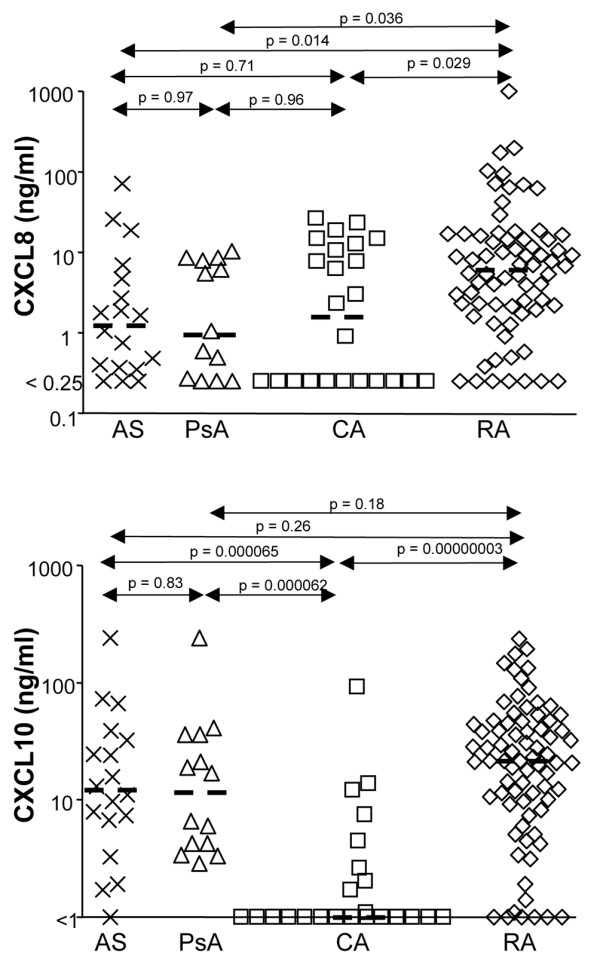
CXCL8 and CXCL10 in synovial fluid of arthritis patients. (a) CXCL10 and (b) CXCL8 concentrations were measured by ELISAs in synovial fluids of patients with ankylosing spondylitis (AS), psoriatic arthritis (PsA) and rheumatoid arthritis (RA), and were compared with chemokine concentrations in the metabolic arthritis patients with crystal-induced arthritis (CA). The detection limits of the ELISAs for the synovial concentrations of CXCL8 and CXCL10 are indicated on the y axis (logarithmic scale) and were 0.25 ng/ml and 1 ng/ml, respectively. Statistical analysis was performed with the median levels (dashed bars) using the nonparametric Mann–Whitney U test.